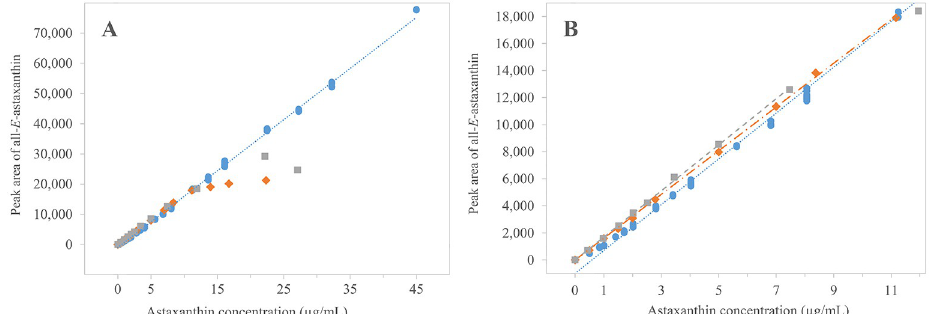
Fig 2. Calibration curves of differently processed astaxanthin standards. B close-up from A including the linear regressions through zero of the standards in petroleum ether and acetone mixture. ● all- E -astaxanthin standard in acetone ┉ linear f(x) = 1693.4x-990.57, R 2 = 0.9985, ◆ all- E -astaxanthin standard in petroleum ether-acetone mixture ╸━ ╸ linear f(x) = 1615.3x, R 2 = 0.9995, ◼ deesterified astaxanthin monopalmitate in petroleum ether-acetone mixture ╸╸╸ linear f(x) = 1702.0x, R 2 =